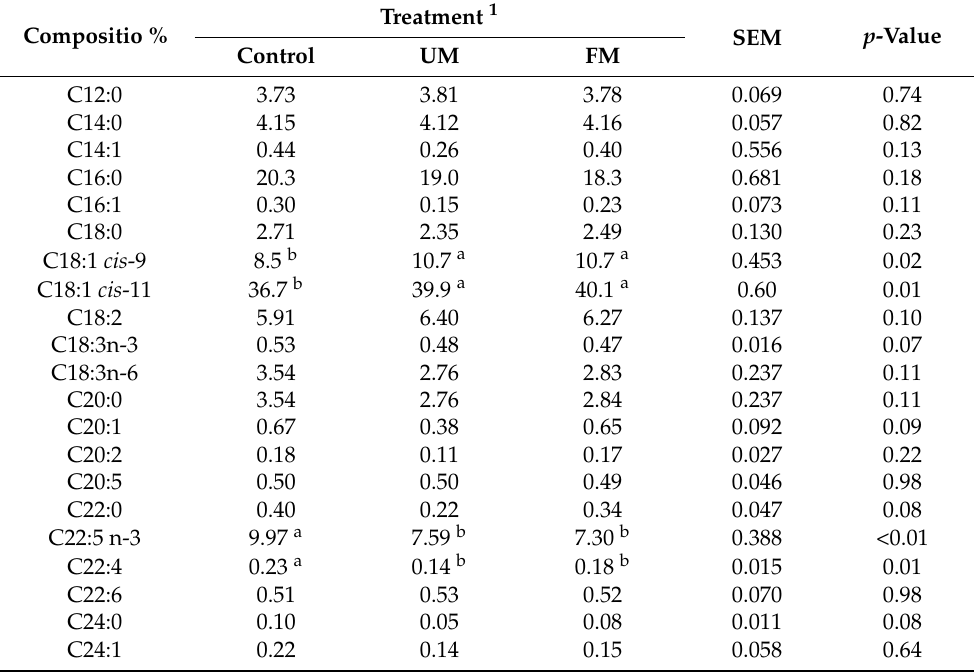
The SFA was lower in cows fed UM and FM, while UFA (mono- and poly-) was higher than the control cows ( p < 0.01). Table 3. The plasma fatty acids compositions of cows fed the total mixed rations (TMR) containing unfermented (UM) and fermented yellow wine lees mix (FM). Treatment 1 Compositio % SEM p -Value Control